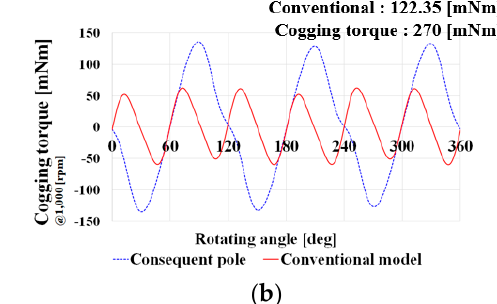
Figure 3. Cogging torque and back emf waveform for conventional model and consequent pole: ( a ) noload phase back emf; ( b ) Cogging torque